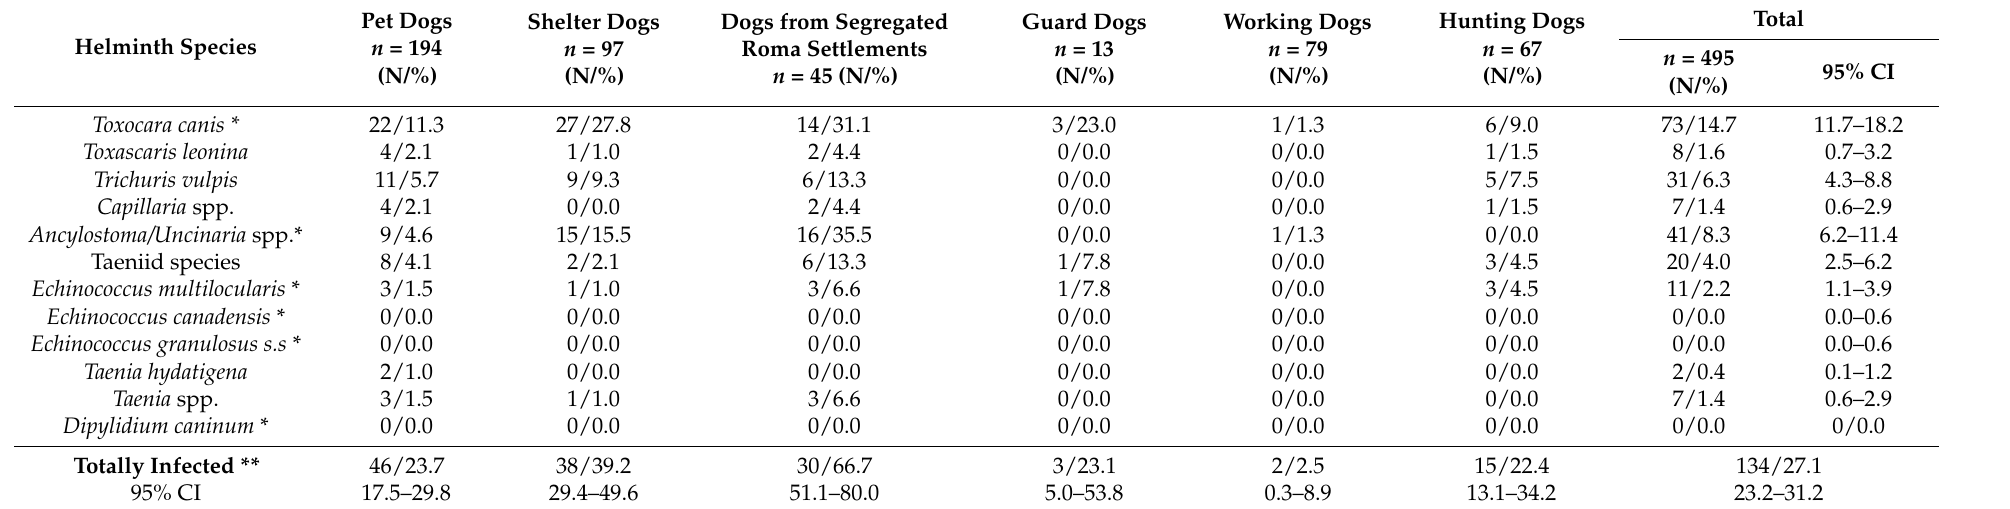
Table 1. Occurrence of intestinal helminths in dogs based on their origin.